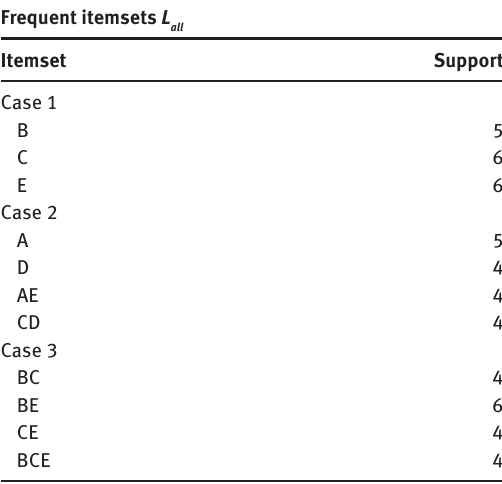
for the updated database DB all